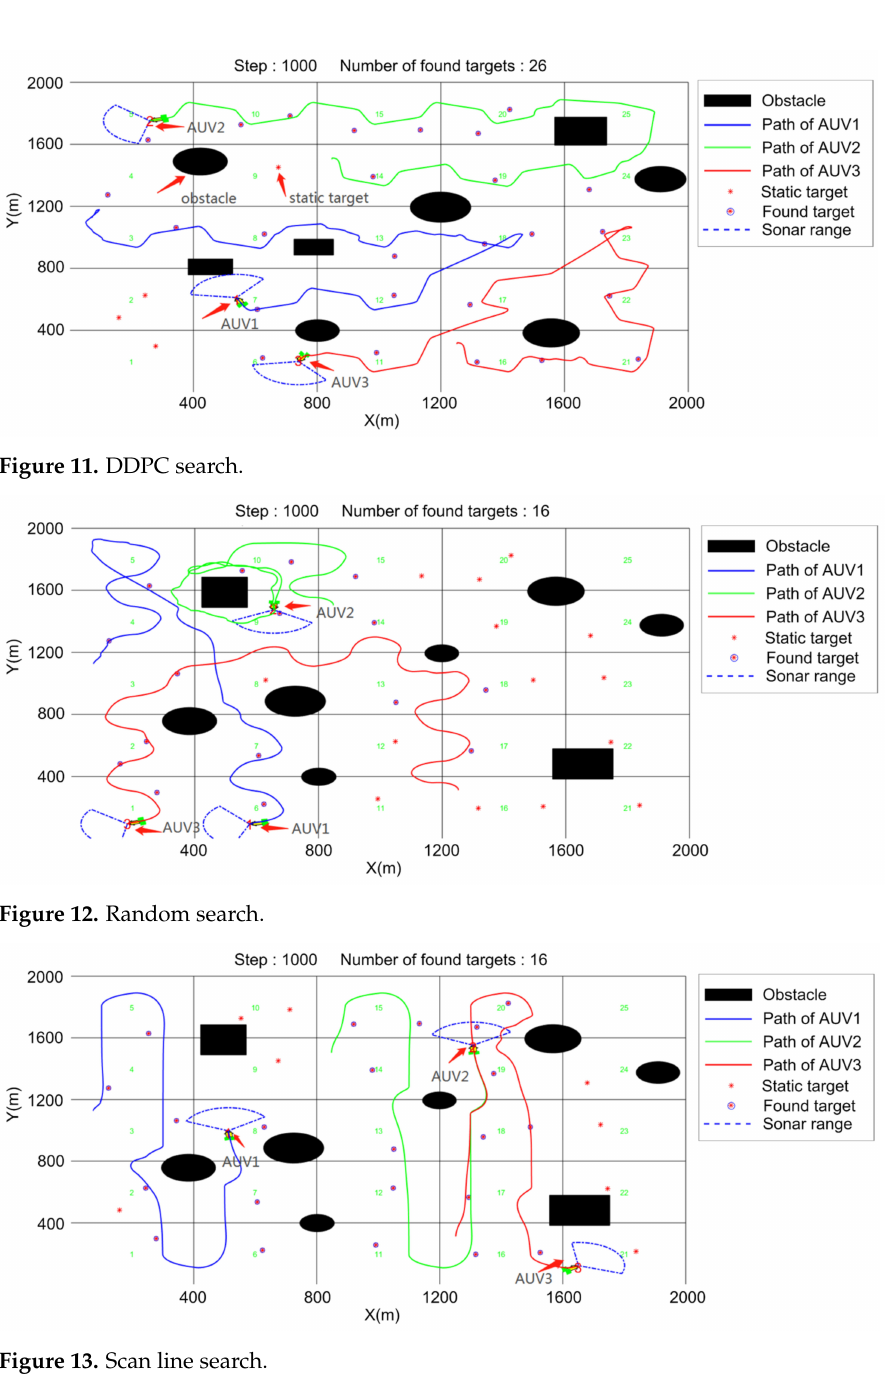
Figure 13. Scan line